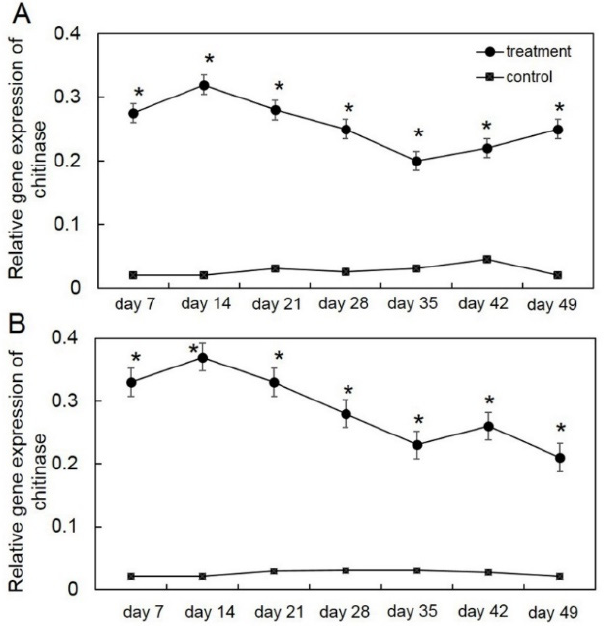
Figure 1. Relative gene expression of chitinase in the first crop ( A ) and second crop ( B ) through reverse transcription quantitative PCR (RT-qPCR) in Trichoderma asperelloides PSU-P1-treated muskmelon plants and control plants. * Indicates a significant difference between treatment and control according to Student’s t -test with p < 0.05.